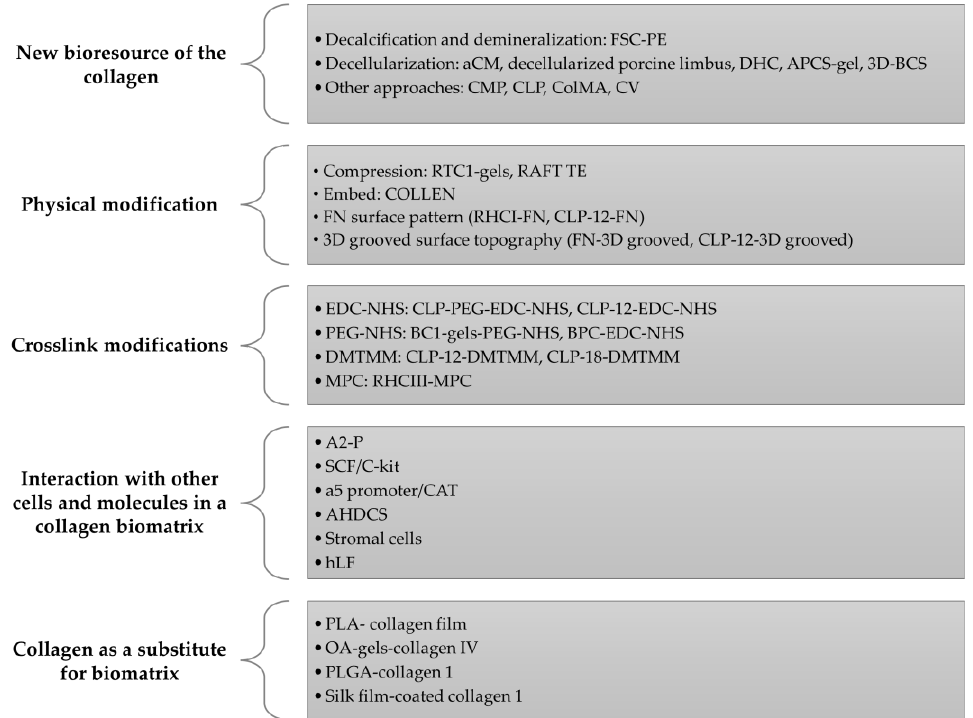
Figure 4. Schematic diagram on the methods or strategies used in the modification of the collagen biomatrix for the last 10 years based on selected articles.